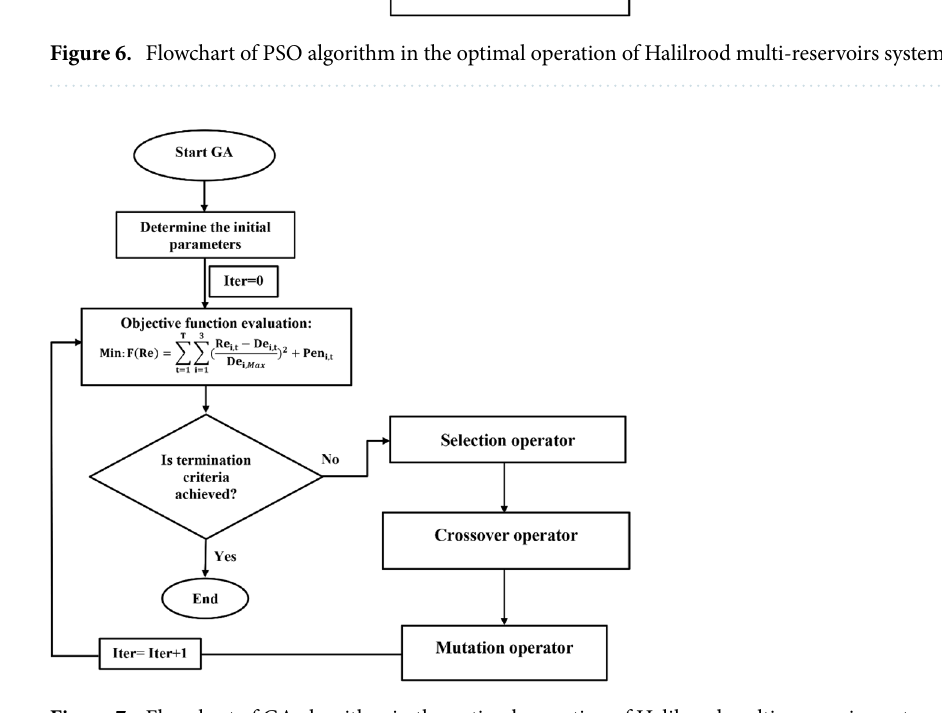
Figure 7. Flowchart of GA algorithm in the optimal operation of Halilrood multi-reservoirs